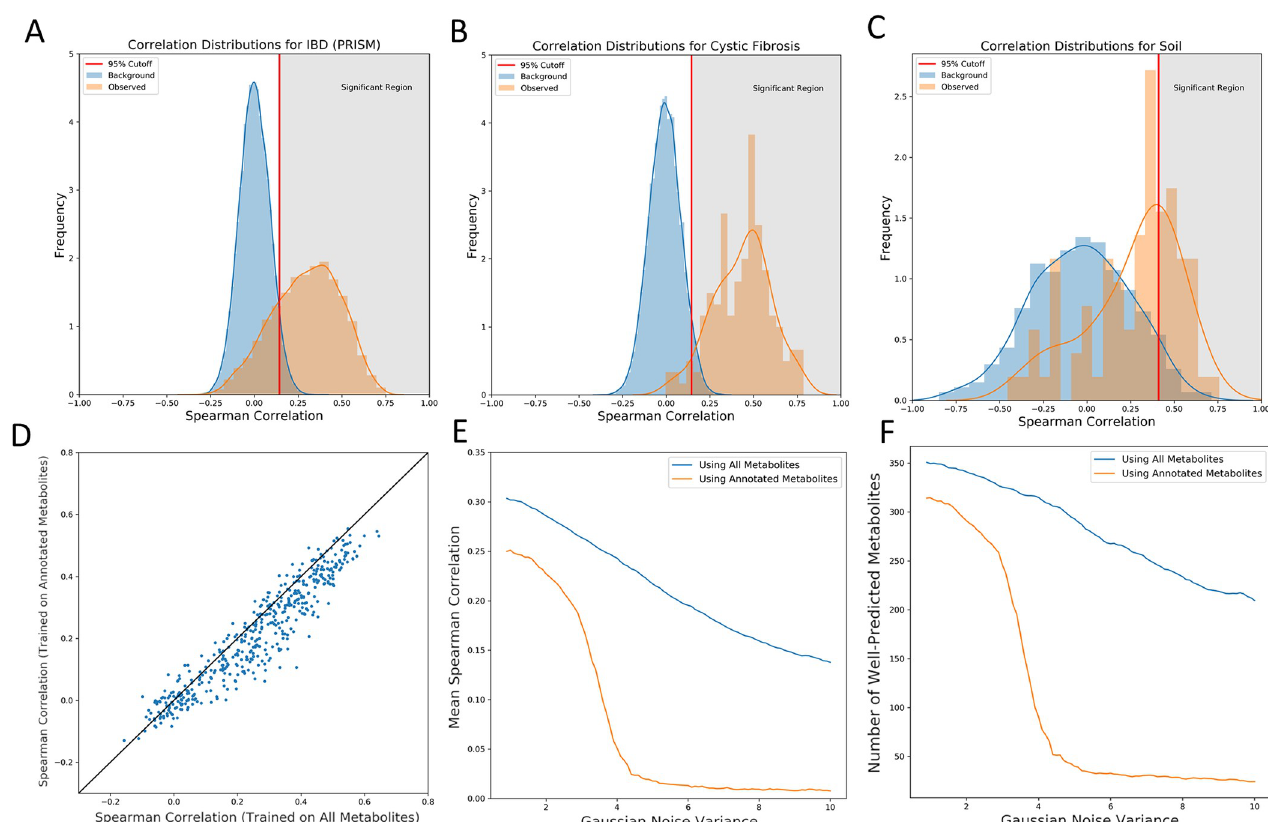
Fig 2. Distributions of correlations (Background and observed) and evaluation of multivariate learning. Background (blue) and observed (orange) distributions are shown for the (A) IBD (PRISM), (B) cystic fibrosis, and (C) soil datasets. The red vertical line denotes the 95 th percentile of the background correlations and the gray area represents the well-predicted region using this threshold. (D) Scatter plot comparing the annotated metabolite correlations between models trained on just the annotated set and models trained on the full set of metabolites. (E) Mean correlation and (F) number of well-predicted metabolites found in models trained on the annotated set of metabolites and full set of metabolties as Gaussian noise is added to the annotated metabolite set input. All results in (D)-(F) are for prediction of the annotated metabolites.